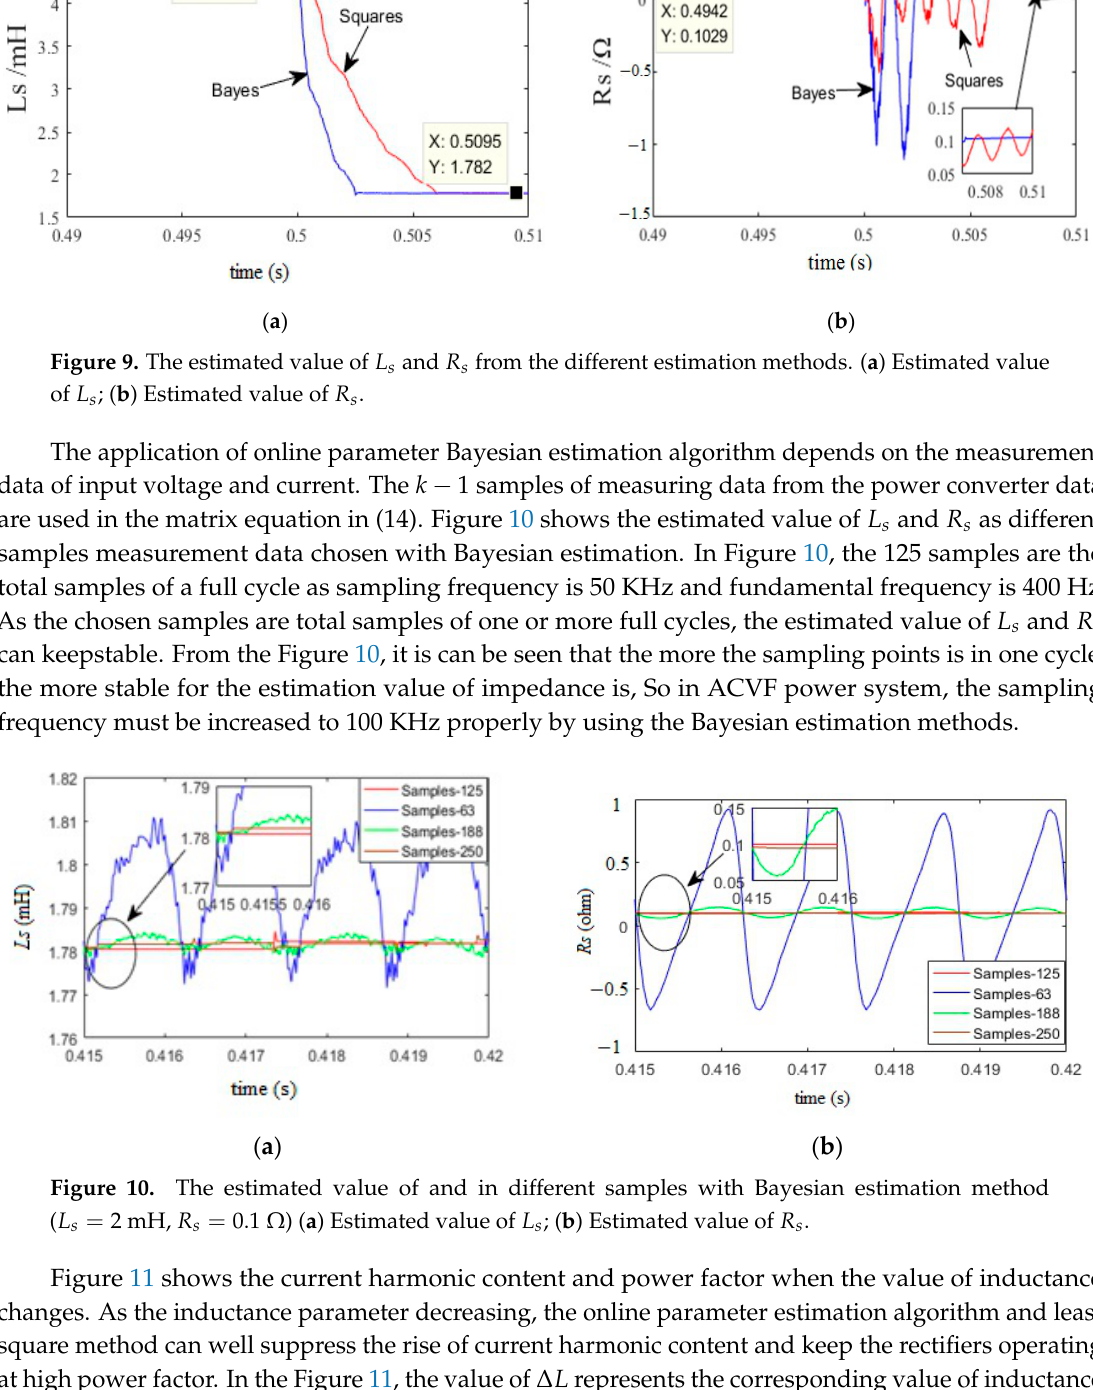
Figure 9. The estimated value of L s and R s from the different estimation methods. ( a ) Estimated value of L s ; ( b ) Estimated value of R s .